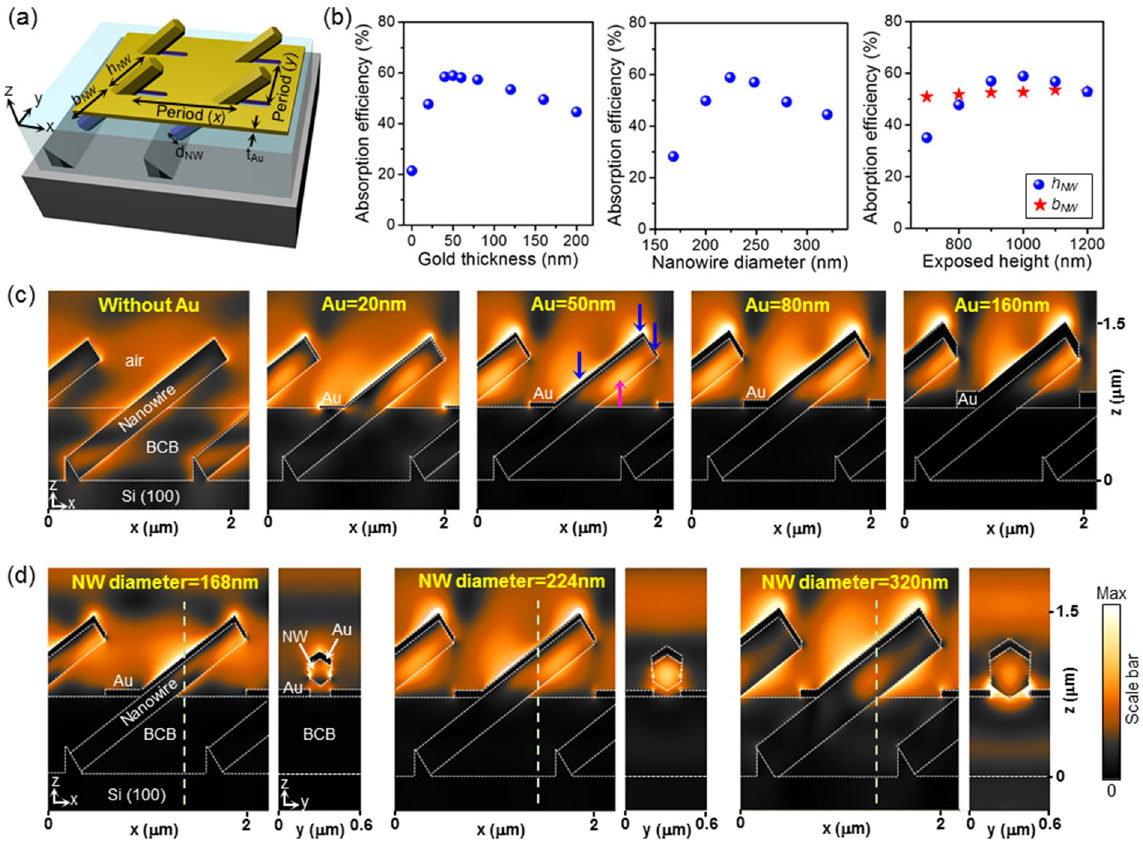
Figure 2. Plasmonic/photonic hybrid mode in nanowires. ( a ) Close-up schematic of meta-absorber structure with dimensional parameters. ( b ) Absorption efficiency of nanowires as a function of gold thickness, nanowire diameter, and exposed/buried nanowire height. ( c ) Electric field profiles (| E |) of the structure for various thicknesses of gold, showing the transition from photonic modes to plasmonic modes by increased thickness. ( d ) Electric field profiles (| E |) of the structure for various nanowire diameters. The profiles of yz -plane are plotted along the dashed lines in xz